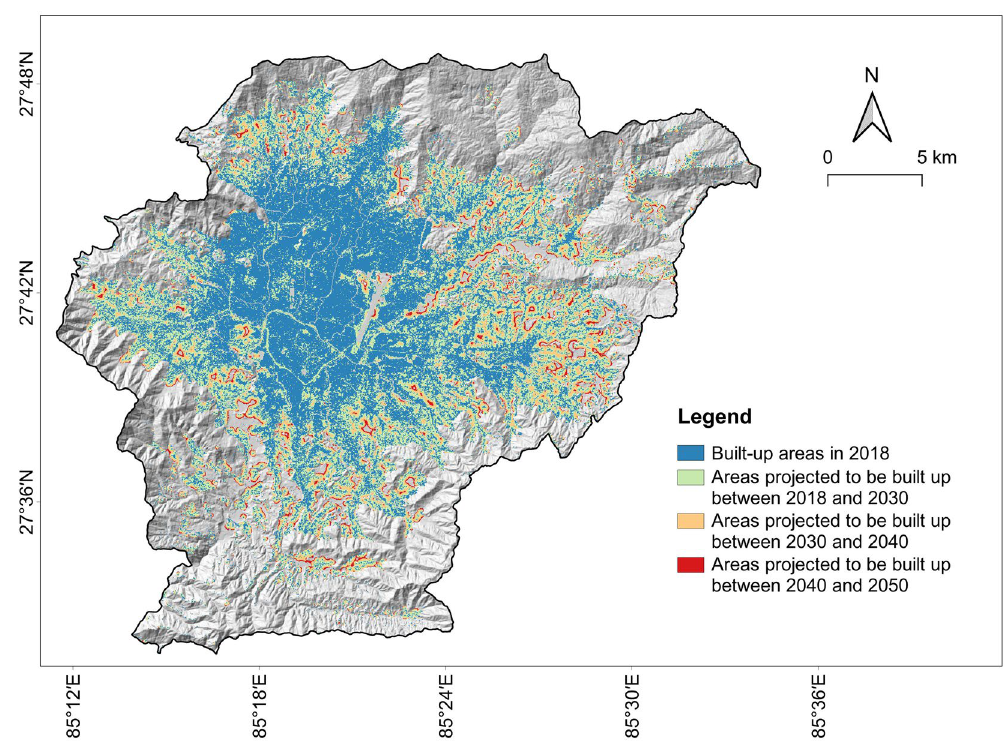
Figure 4. Existing built-up areas in Kathmandu Valley (as of 2018) and projected built-up areas by